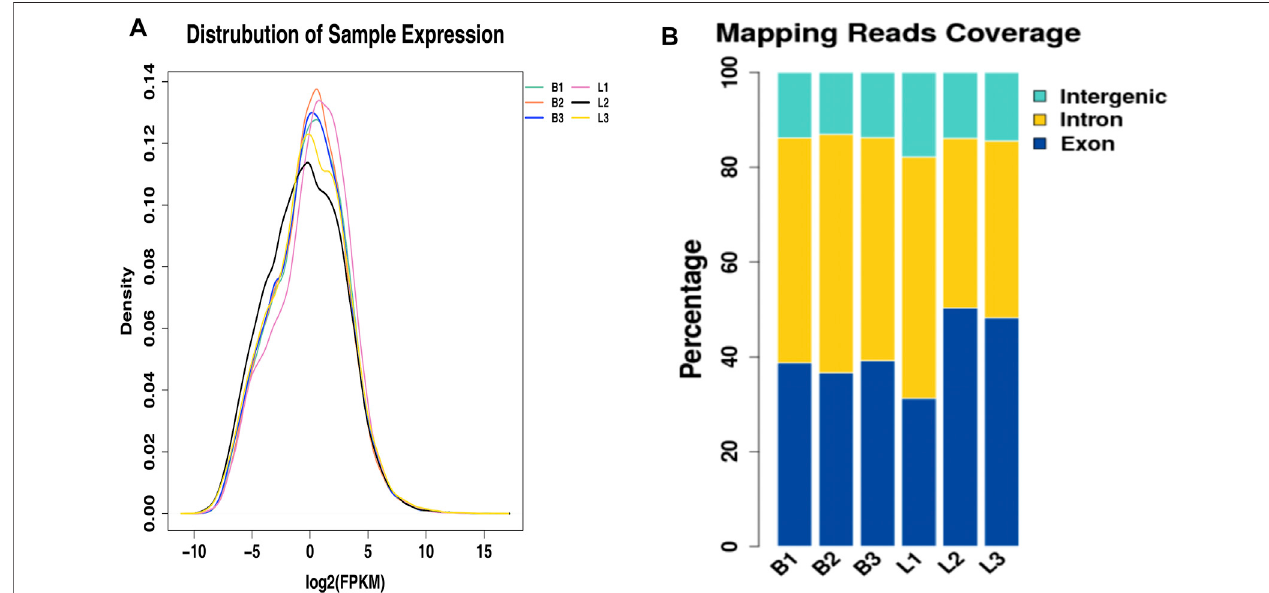
FIGURE 2 | The relative expression and the genome distribution of potential transcripts and clean reads. (A) The new transcripts were relatively expressed in longissimus dorsi muscle of Shandong black cattle and Luxi cattle, and the density distribution map wasmade after taking logarithm of 2as thebase. Theabscissa was log2(FPKM+0.0001),andtheordinatewasgenedensity.Differentcolorsrepresentdifferentsamples. (B) Theresultsshowedthatthegenomicdistributionofcleandata oflongissimusdorsimuscletissueofShandongblackcattleandLuxicattlewasgenomedistribution;theabscissawaseachsample,andtheordinatewastheratio of the sequence number of exon, intron and intergenic region between the reference